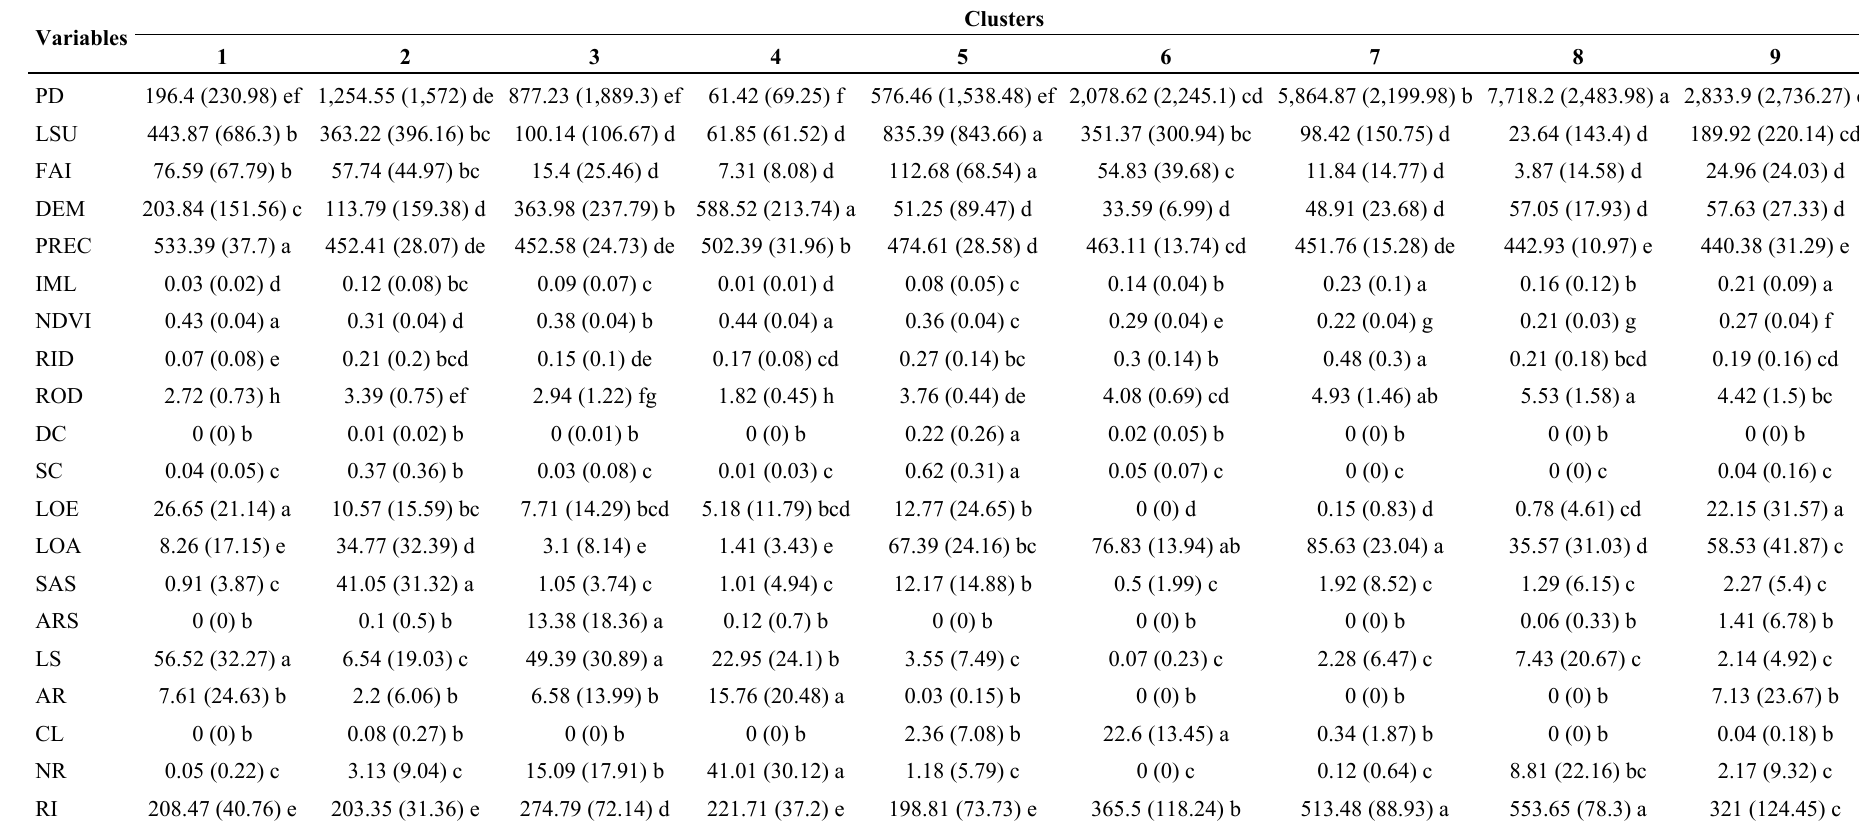
Note: Different alphabet letters indicate significant differences among the clusters based on Dunn’s multiple comparison tests at the 0.05